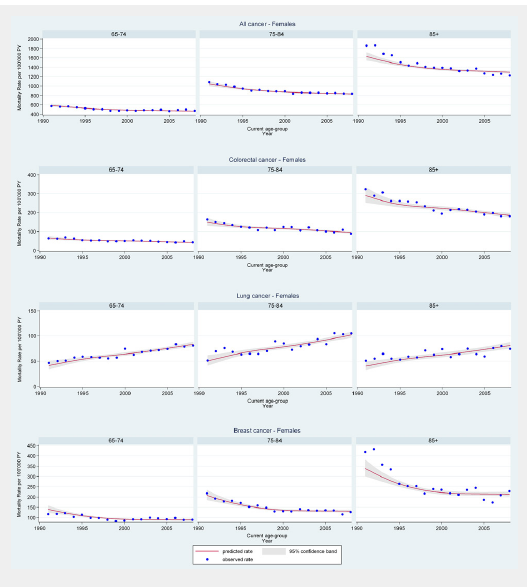
Age-specific cancer mortality from 1991 through 2008 in Swiss women ≥65 years